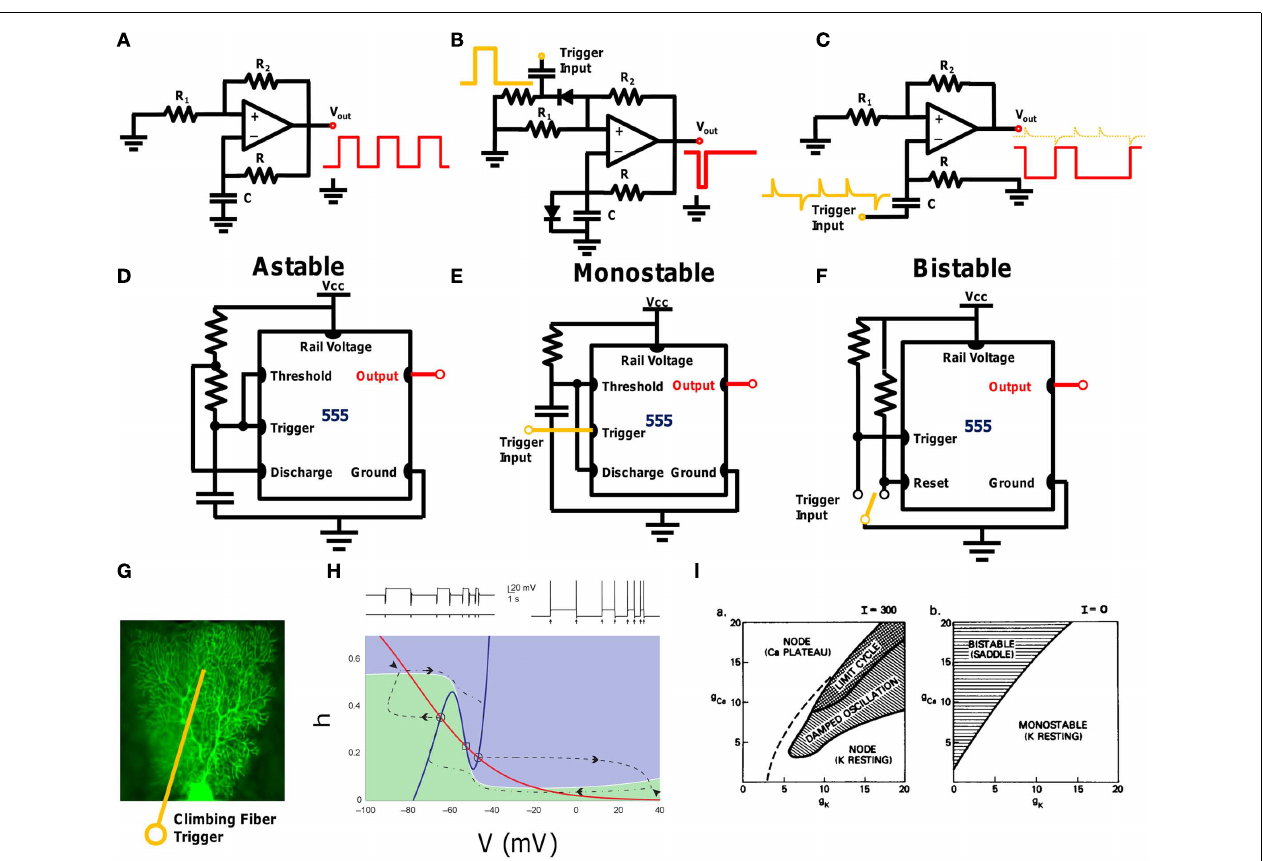
neuron with the climbing-fiber acting as an external trigger, as was demonstrated experimentally by others (see Figure 4 ). (H) Dynamic systems model of Bistability with an external trigger (Loewenstein et al., 2005).The circles signify the stable states in phase space. External triggers (excitatory or inhibitory) can shift the stability to another state. (I) Original description of a two-parameter Morris–Lecar model system providing all three modes of multivibrator operation as a function of the current and gating variables.The Morris–Lecar model is generalized for any neuronal system (Morris and Lecar,